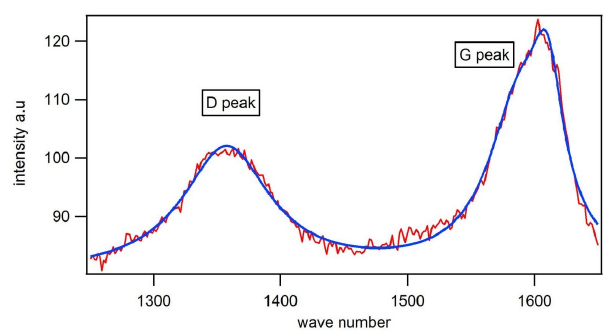
Figure 12. Raman spectrum fitted to Lorentzian function, I D / I G < 1 .